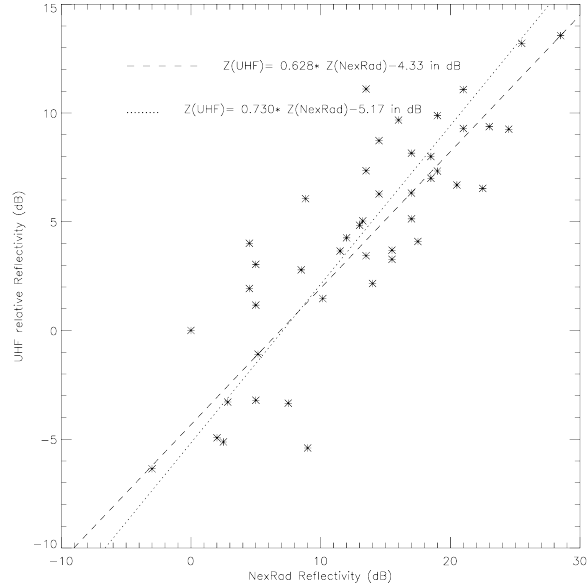
Fig. 8. UHF corrected reflectivities as a function of the NexRad reflectivities for all 4 altitudes of Fig. 7. The two lines represent the extreme values of the slope, g o , assuming different values of the errors, σ , on each data set, following the approach of Hocking et al.